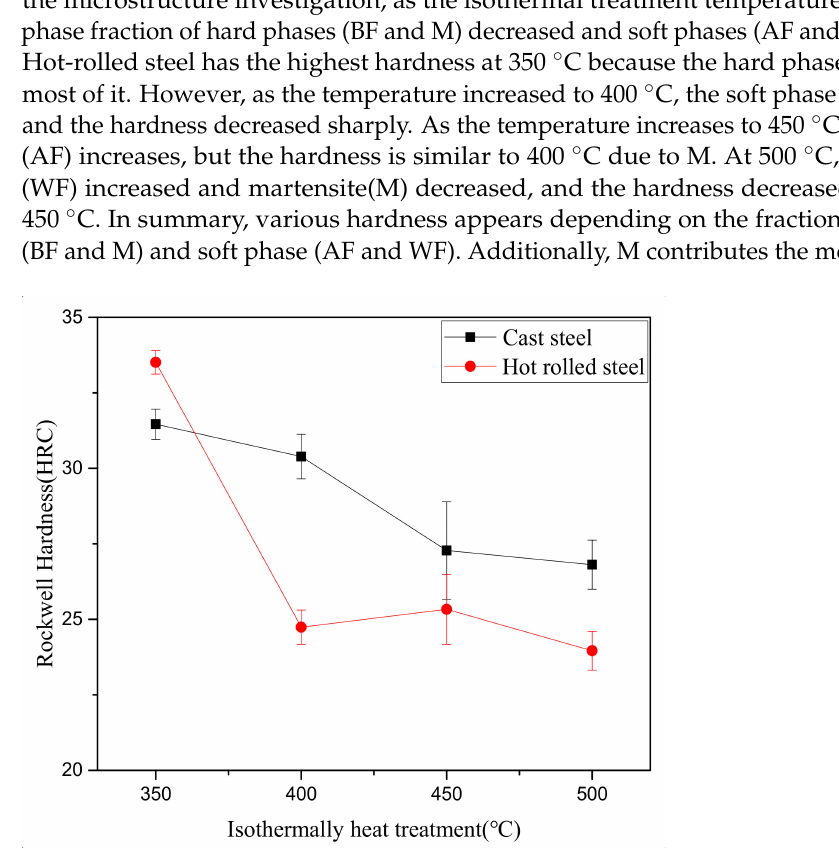
Figure 10. Variation in the hardness of medium-carbon low-alloy steel with the isothermal heat- treatment